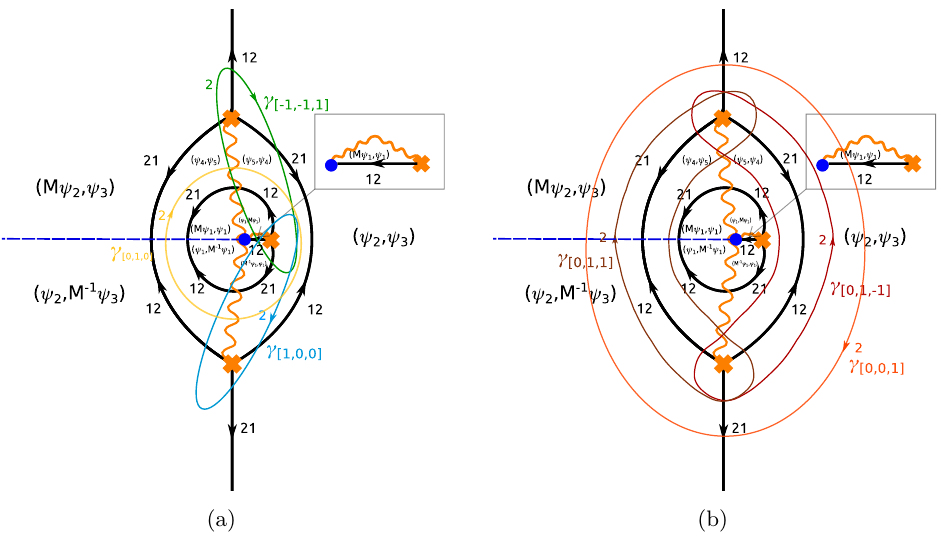
Figure 10 . The spectral network W ϑ =0 for u = 2 , m = 0 , Λ = 1 / 5 in the weak coupling region. The blue dotted line is the monodromy cut. The local basis of solutions in each domain is listed as ( ψ (1) , ψ (2) ) . The two figures are identical except that we show different bases for the charge